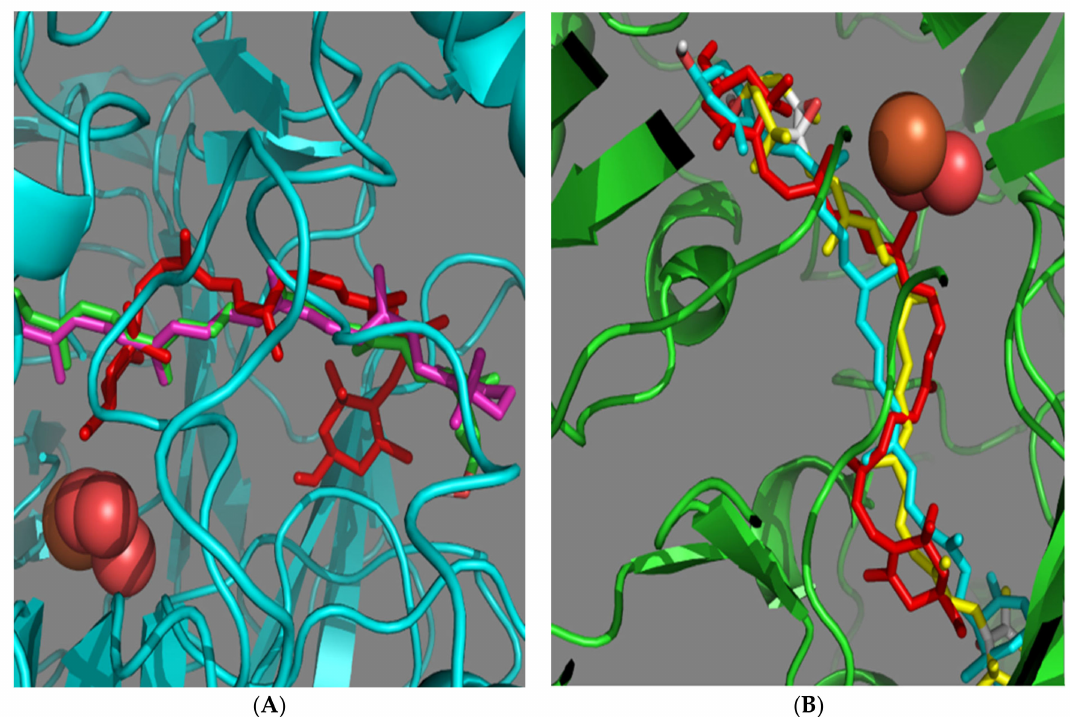
Figure 7. Visualization of carotenoid docking ( A ) on the mBCO2 protein I-TASSER model (lutein in green and β -carotene in purple, zeaxanthin in red and protein in cyan) and ( B ) on the mBCO2 protein Swiss-Model model (violaxanthin in yellow, lutein in cyan, zeaxanthin in red and protein in